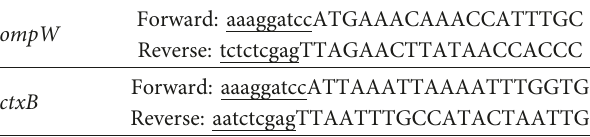
Table 2: The primer sets used for amplification of ompW and ctxB